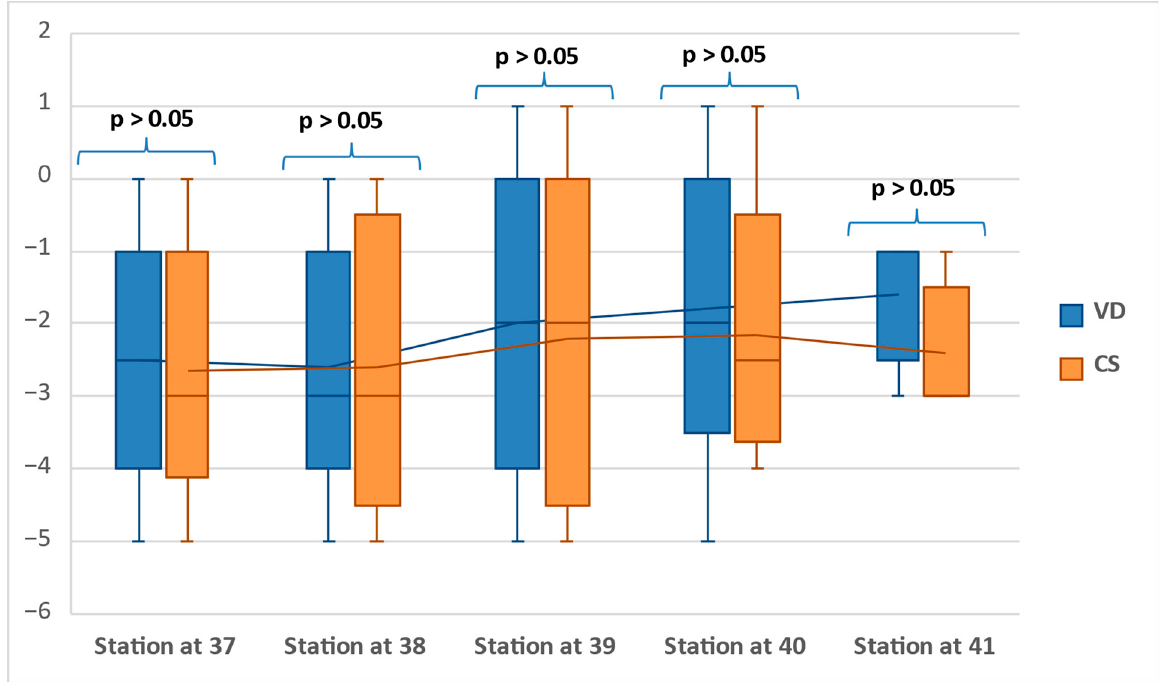
Figure 2. Box plot showing the distribution of the fetal head station at 37 to 41 weeks of gestation. The median determinations of clinical FHS at 37 to 41 GW were similar between the two groups: − 2.5 vs. − 3 at 37 GW, − 3 vs. − 3 at 38GW, − 2 vs. − 2 at 39 GW, and − 2 vs. − 2.5 at 40 GW. A more important difference was noted at 41 GW: station − 1 for vaginal deliveries compared with station − 3 for Cesarean